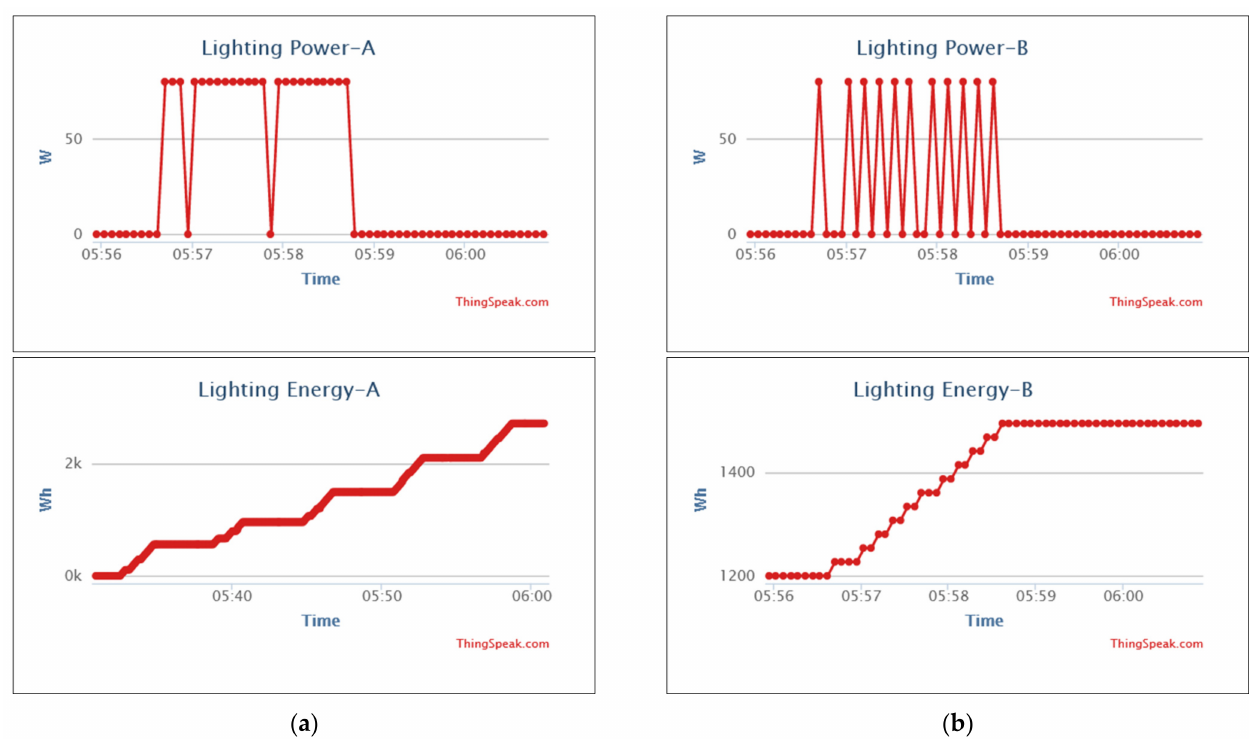
Figure 9. Line chart display for ThingSpeak: ( a ) lighting power and energy of Model-A; ( b ) lighting power and energy of